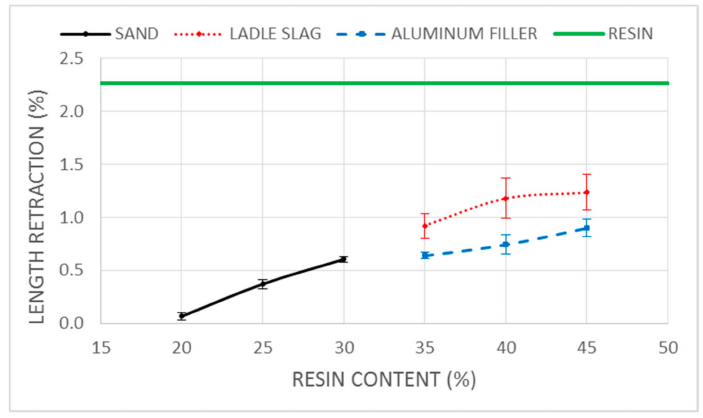
Figure 3. Length retraction test